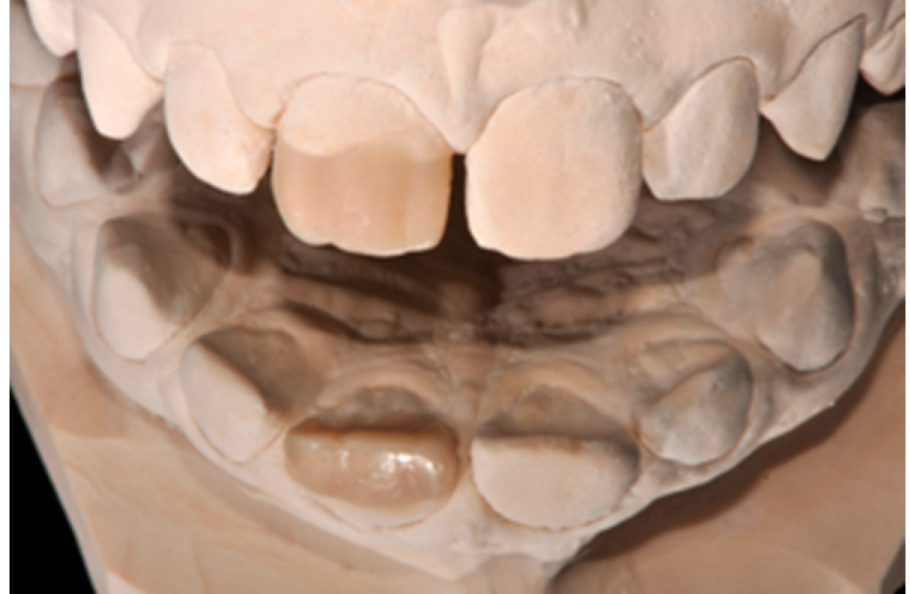
Figure 3. Wax-up. Reprinted from Restauri diretti nei settori anteriori, G. Paolone, S. Scolavino, © 2021, with permission from Quintessence Publishing Italy.